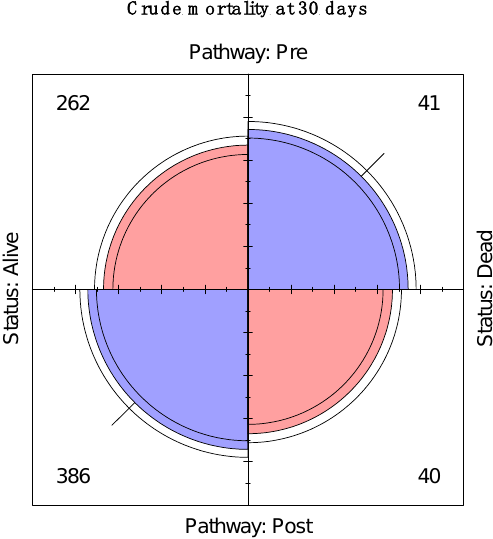
Figure 7. Cumulative 30-day mortality data.